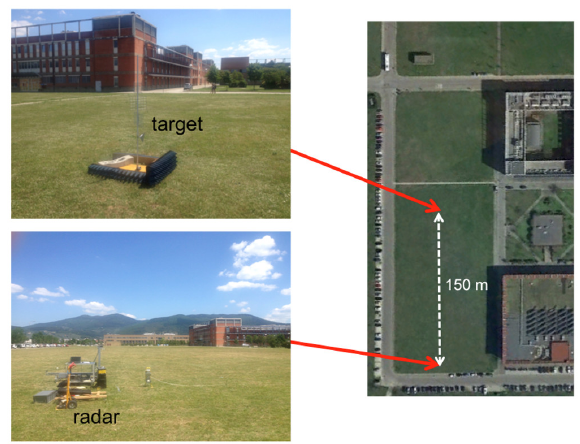
Figure 9. Experimental test site “Campus”. Table 1. PSNR calculated with different bases and recovery methods for experimental data acquired at the test site